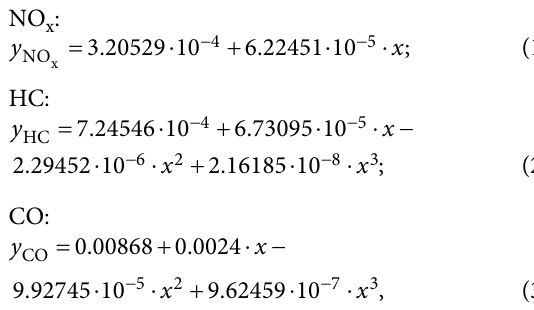
curveraw regression